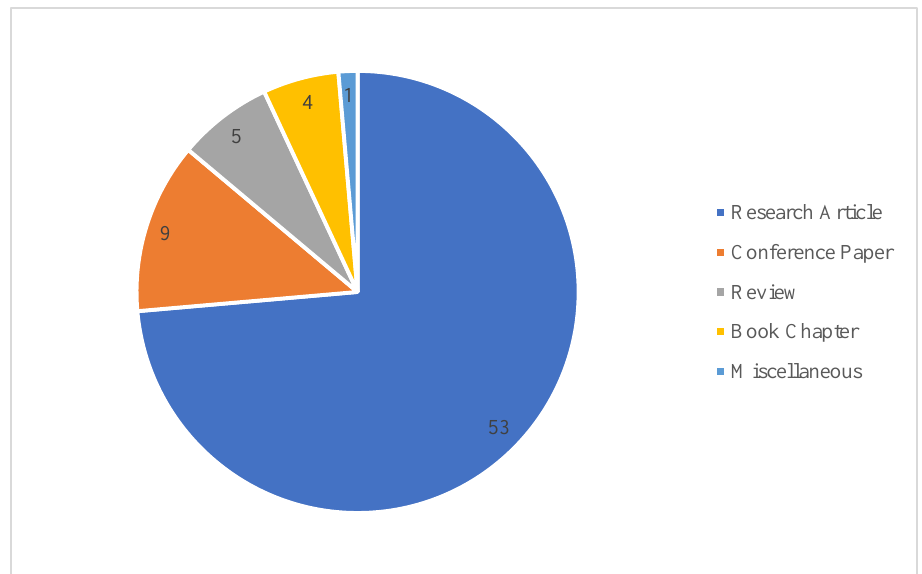
Figure 4. Trends of publications in the common area of the business models and the foods from 1999 to 2019.